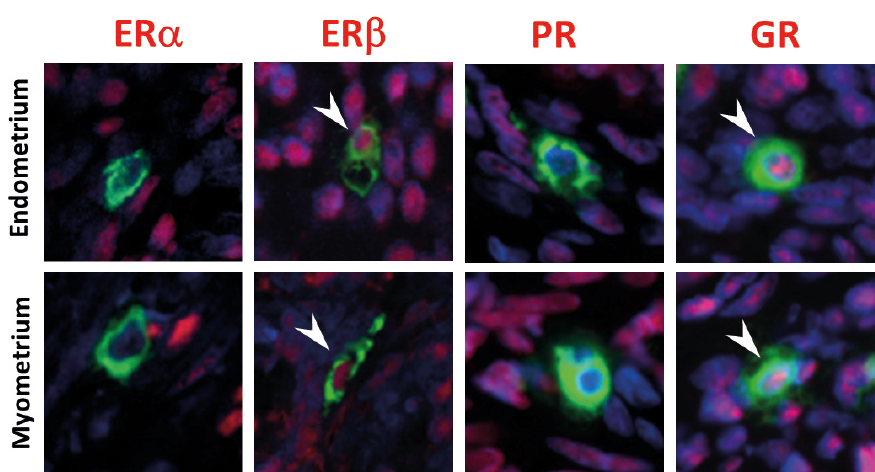
Figure 7. Summary immunoexpression of steroid receptors in human uterine mast cells. Uterine mast cells are immunopositive for ER β and GR, and immunonegative for ER α and PR. (Red staining: ER α , ER β , PR and GR; green staining: tryptase). Arrowheads point to nuclei that have immunopositive (red) staining for ER β and